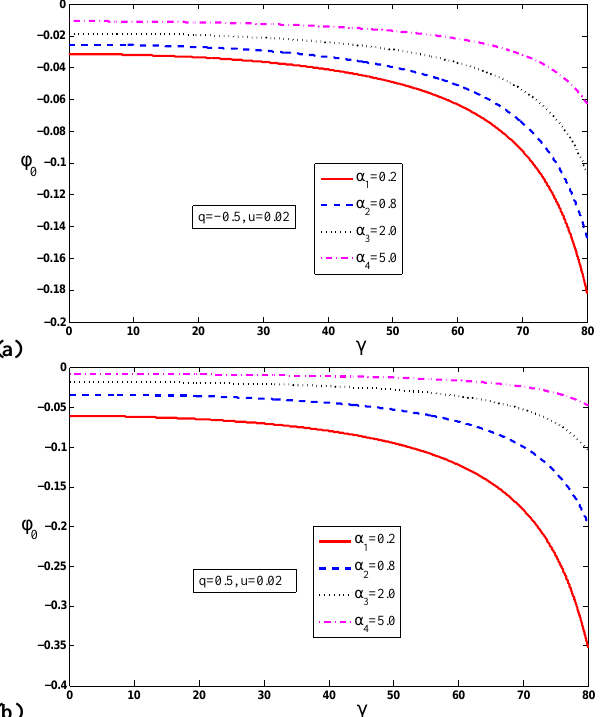
Fig. 5. (a) Soliton width with respect to l z with q = − 0 . 5 and dif- ferent values for the parameter ω cc . (b) Soliton width with respect to γ with q = 0 . 5 and different values for the parameter ω cc